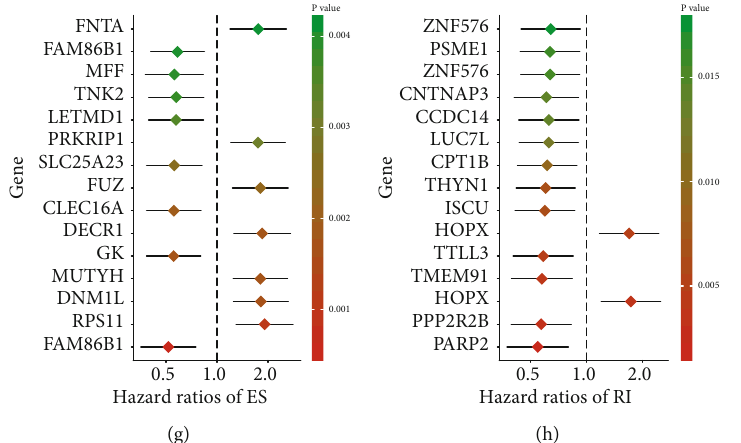
Figure 2: AS events and prognosis in glioma. (a) The number of survival-related AS events and related genes in each type of di ff erential AS. (b) Circos diagram of survival-related AS events and related genes: the Circos panel from outside to inside is expressed as follows: chromosome number, genome axis, and survival-related AS event-related genes; the number of related genes in the overall AS event (showing 1-10 di ff erent heights, more than 10 calculated as 10); correlation; the number of AS types of genes in the overall event; the p values of related genes in the single-factor COX regression analysis (expressed by the conversion value of − log 10 ð p values Þ ; the higher the height, the more signi fi cant the p value); the HR value of correlation genes in the univariate COX regression analysis (in which red represents HR > 1 and black represents HR < 1 ); and the correlation between genes. (c – h) Forest diagram of top 15 AS events related to survival in each AS